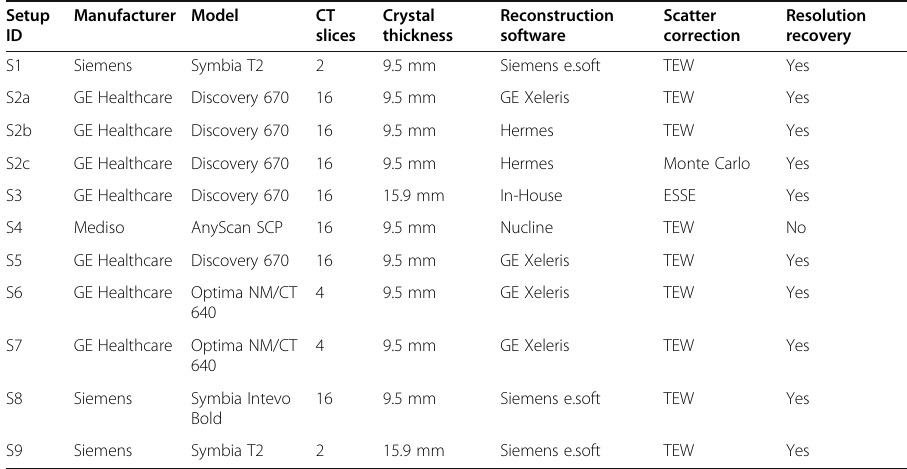
Table 1 Details of SPECT/CT systems and reconstruction software used in the comparison exercise. TEW , triple-energy window; ESSE, effective scatter source estimation [18,